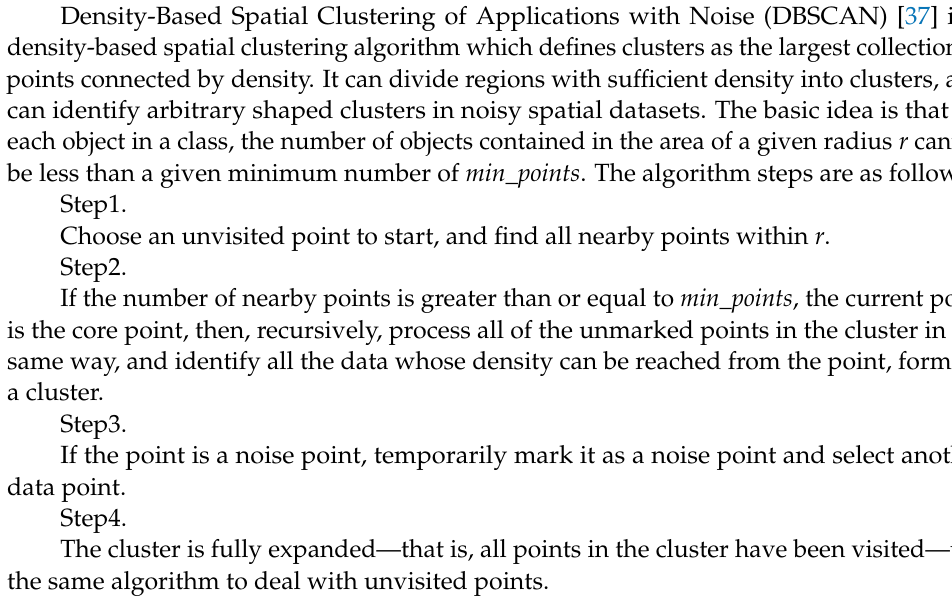
Figure 2. BFS and DFS in Node2Vec.